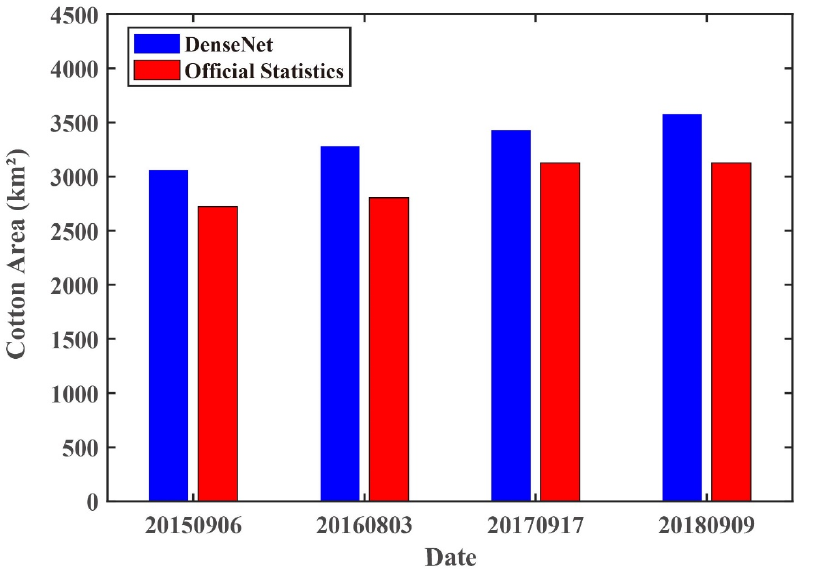
Figure 9. Statistics on the change of cotton field cultivated area from 2015 to 2018 in Wei-ku Oasis, derived from GF-1 images.